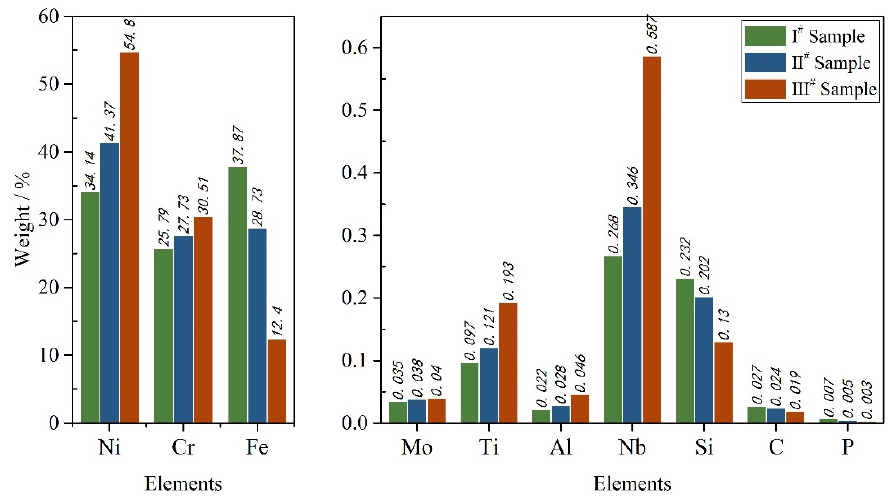
Figure 9. The sensitive elements content.